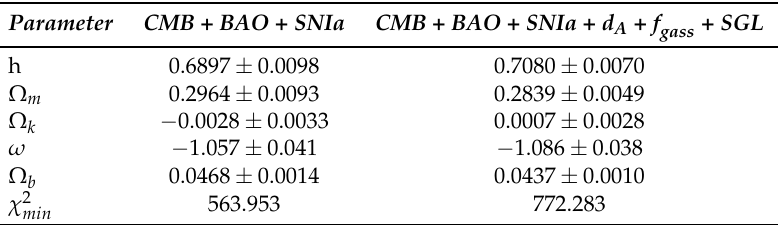
Table 2. Summary of the best fit values for wCDM